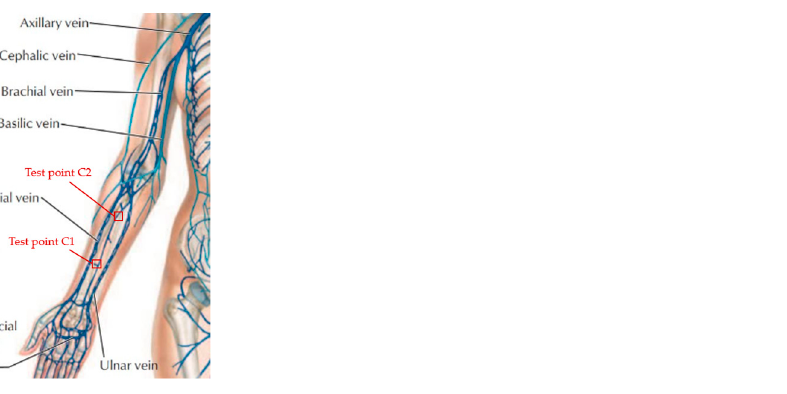
Figure 3. The diagram of major veins of the human arm and position marking of the arm test point. 4.